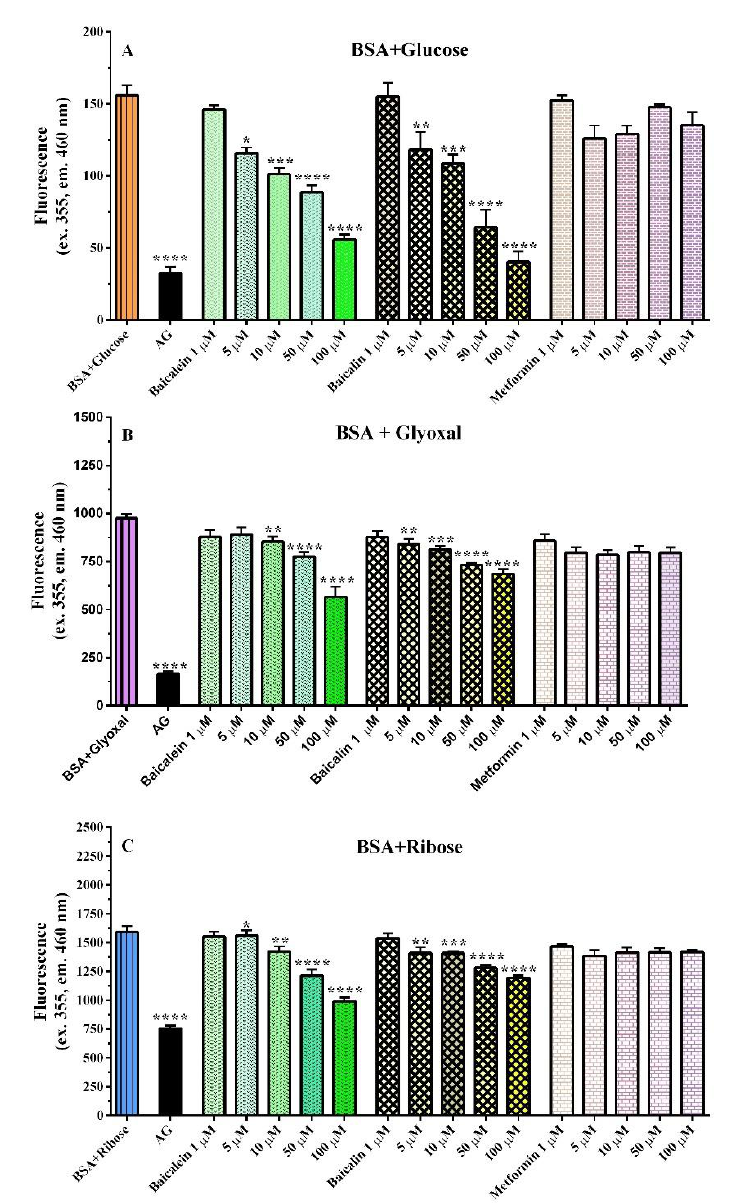
Figure 3. Baicalein (green bars), baicalin (yellow bars), and metformin (pink bars) inhibition of AGE formation after 7( A , B ) or 5 ( C ) days of incubation of 50 mg/mL BSA with 0.8 M glucose ( A ), 0.003 M glyoxal ( B ), and 0.1 M ribose ( C ). Aminoguanidine (2.5 mM, AG) was the positive control. Data are the mean ± SEM of 3–6 experiments. * p < 0.05, *** p < 0.001, *** p < 0.001, **** p < 0.0001 versus BSA glycation (BSA + glycation agent).